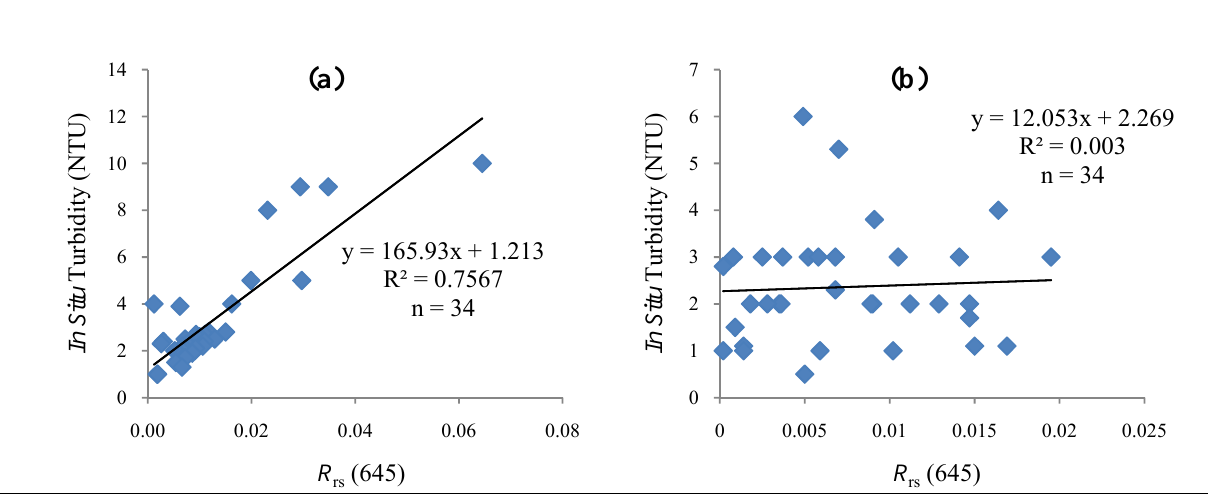
from MOD09GQ. (a) Data collected 8 days after a rs